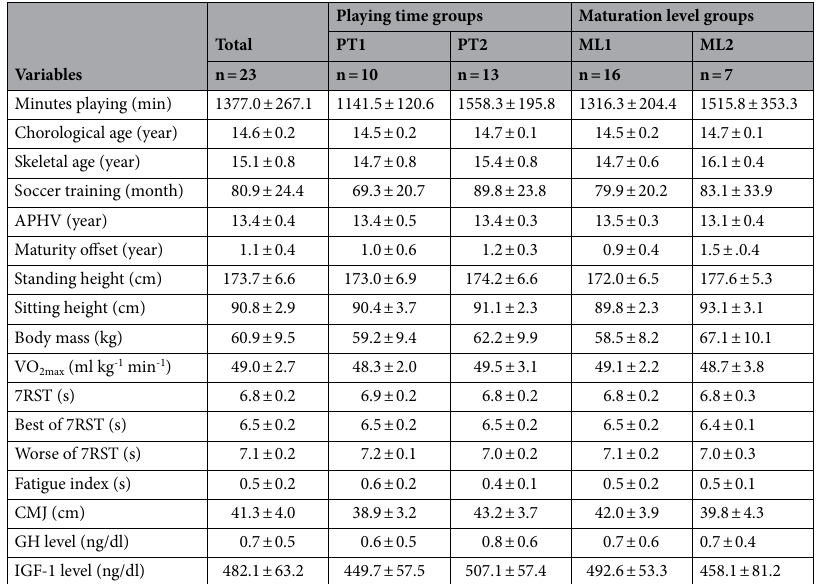
Table 1. Descriptive statistics of playing time and maturity groups in inter-variability of under 15 youth soccer players. PT1 group of player who play less than 50 percent of total season, PT2 group of player who play more than 50 percent of total season, ML1 the group of player who were on normal maturation, ML2 the group of player who were early maturation, APHV age at peak height velocity, VO 2max maximal oxygen uptake, 7RST 7 repeated sprint test, CMJ counter movement jump, GH growth hormone, IGF-1 insulin-like growth